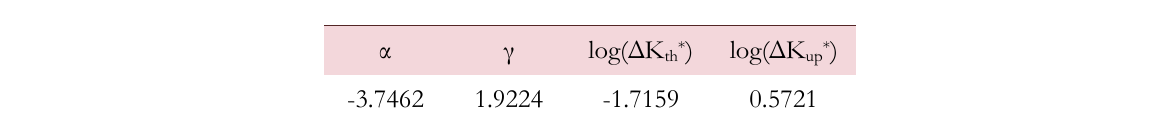
Table 4: Parameter values found by fitting the crack growth rate curve as a cumulative distribution function.